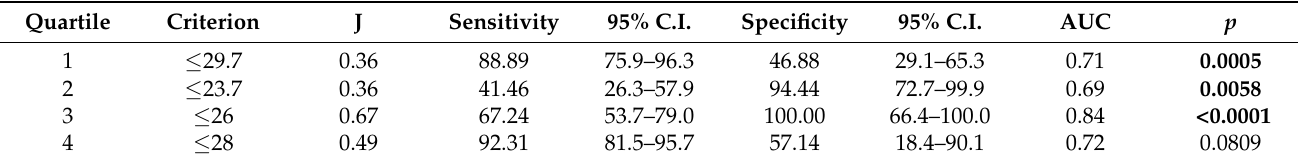
Table 6. Youden’s indexes of the